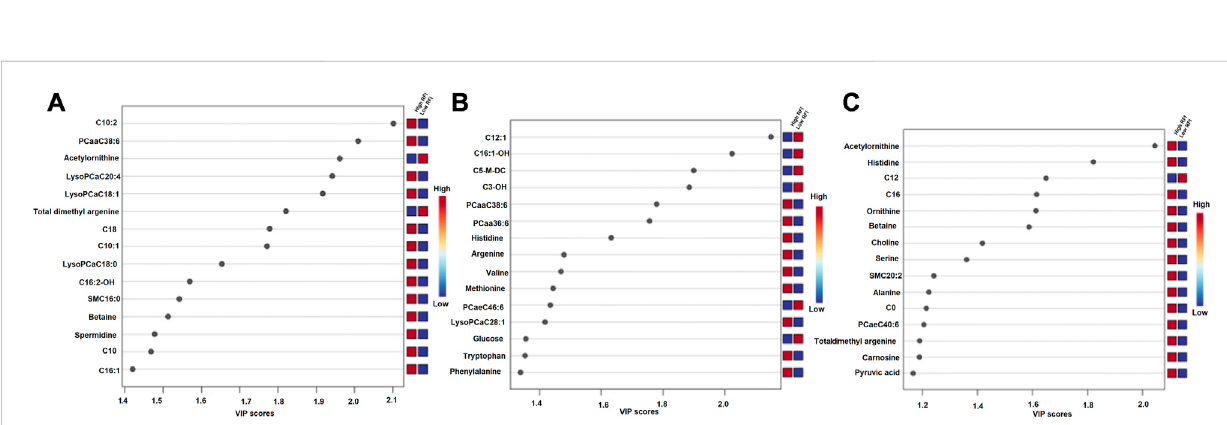
FIGURE 6 Metabolitesrankedbyvariableimportanceinprojection(VIP)attheearly (A) ,mid (B) andlate (C) lactationstages.TheVIPscoreplotsindicatethetop 15 metabolites that distinguished high and low RFI groups at each of the three time